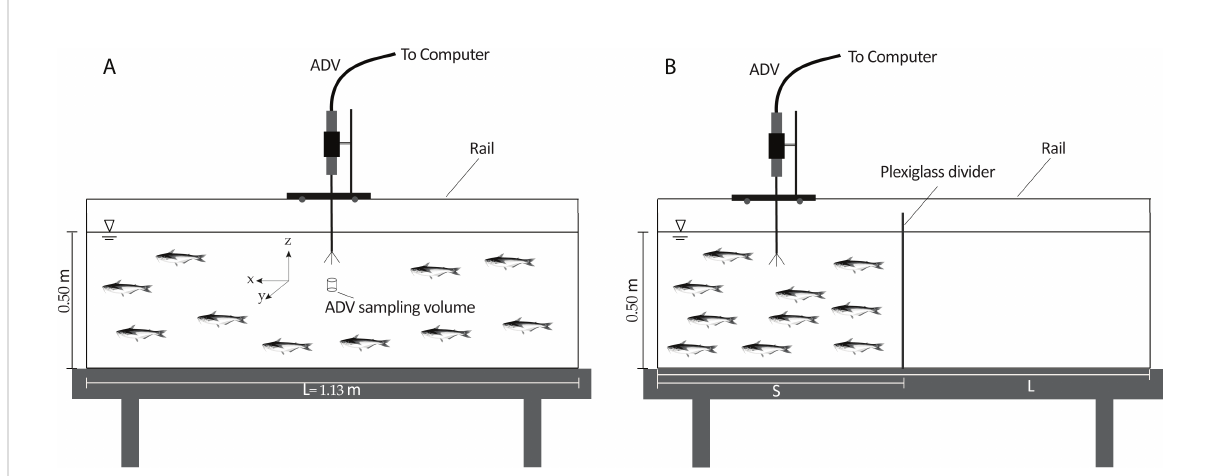
FIGURE 1 The schematic diagram of the aquarium and measurement apparatus, acoustic Doppler velocimeter (ADV) for: (A) the minimum abundance of 50 animal/m 3 , and (B) the abundances of 100 to 300 animal/m 3 created by restricting the water volume using a plexiglass divider ( S = L / n , n =